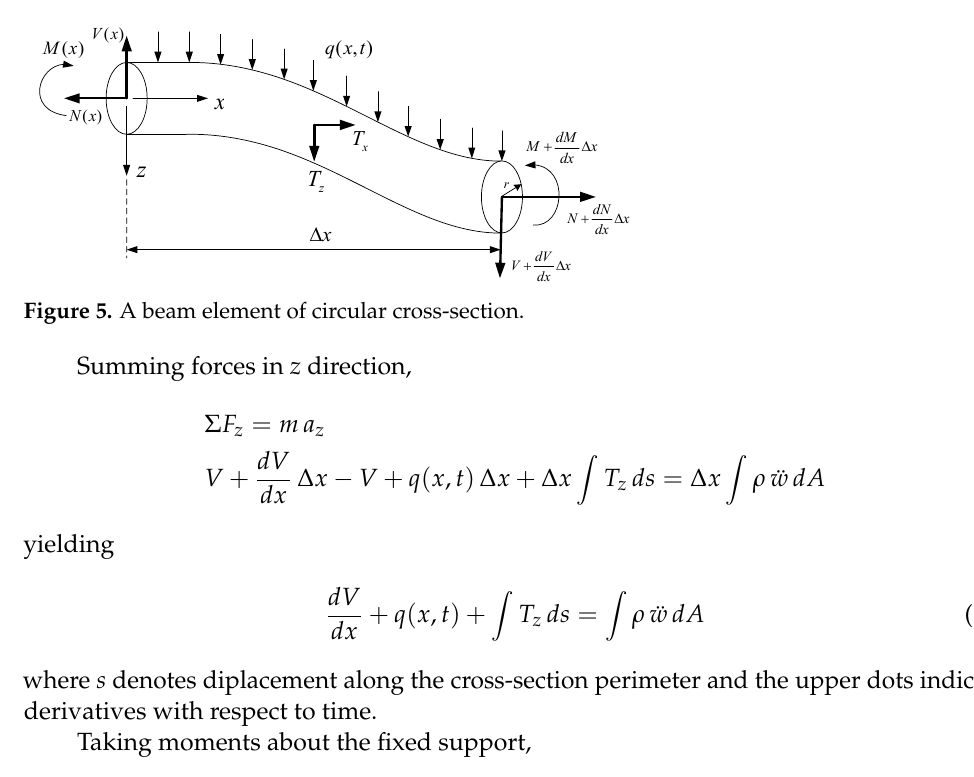
Figure 4. A beam element of rectangular cross-section.